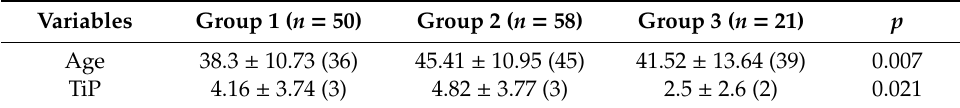
Table 1. Mean, standard deviation and median of age and TiP (total time in prison) study